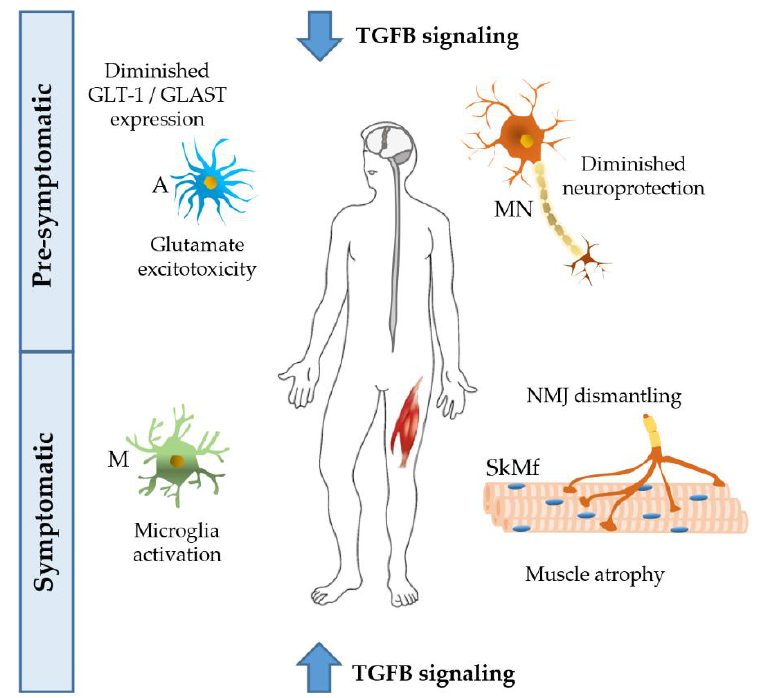
Figure 2. Possible effects of TGFB on different tissues of amyotrophic lateral sclerosis (ALS) patients. At the pre-symptomatic stage, the decreased activation of the TGFB pathway reduces its neuroprotective activity, and, at the same time, increases excitotoxicity induced by glutamate, with a lesser uptake by astrocytes. At the symptomatic stage, TGFB levels are largely increased, giving rise to microglia activation, and neuromuscular junction (NMJ) dismantling, thus leading to atrophy of skeletal muscle fibers. ALS disease progression could be promoted by a chronically altered TGFB pathway. A, astrocyte; M, microglia; MN, motor neuron; SkMf, skeletal muscle fibers.